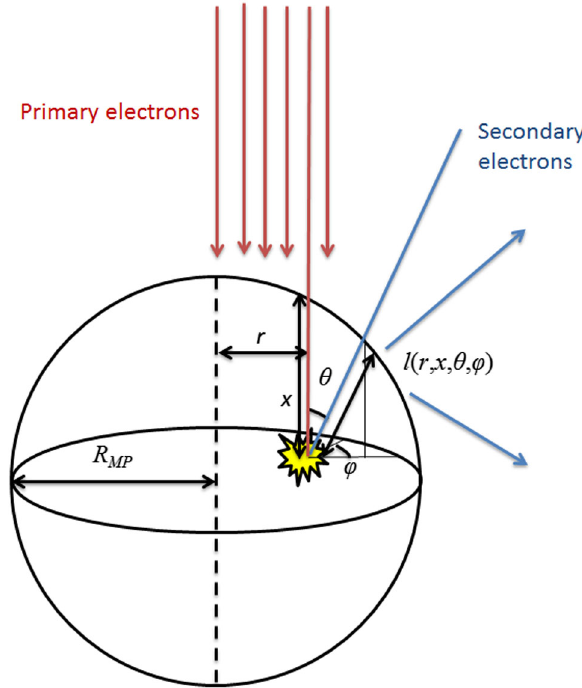
FIG. 8. Secondary electron yield induced by electron bombard- ment for a 10 μ m radius